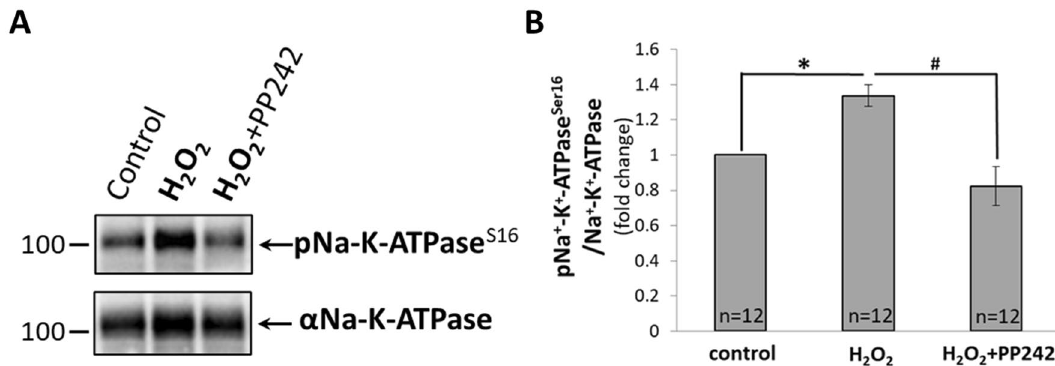
Figure 6. ( A ) Representative Western Blot of total Na + -K + -ATPase and phosphorylated Na + -K + -ATPase (pNa + - K + -ATPase Ser16 ) in mTAL isolated from SD rats. mTAL incubated in HBSS for 20 min ( control ); incubated 10 min in HBSS and then with 100 µM of H 2 O 2 for another 10 min ( H 2 O 2 ); incubated with 10 µM of PP242 for 10 min and with 100 µM of H 2 O 2 for another 10 min ( H 2 O 2 + PP242 ). ( B ) Activity of Na + -K + -ATPase pump determined by densitometric quantification expressed as the ratio of pNa + -K + -ATPase Ser16 relative to total Na + -K + -ATPase. Data were normalized to control and represented as mean ± S.E.M (n = 12). * P < 0.05 between control and H 2 O 2 treated mTAL; # P < 0.05 between H 2 O 2 treated and H 2 O 2 + PP242 treated mTAL; determined by Student’s t-Test.